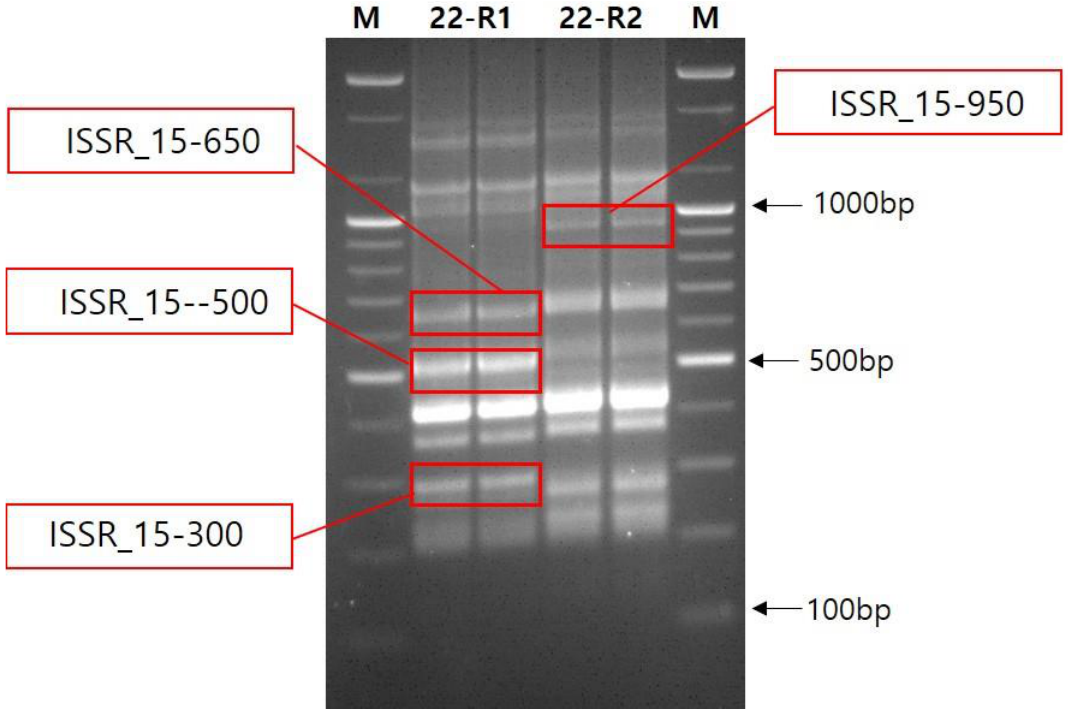
Figure 5. An agarose gel run for sequencing of four polymorphic bands (in red rectangles) produced by ISSR_15 primer from IT245860 accession with TC treatment. M, 100 bp size marker. 22-R1: variant, 22-R2: standard. Table 5. The sequencing analysis of polymorphic PCR bands produced in TC treatment of IT245860 by primer ISSR_15.